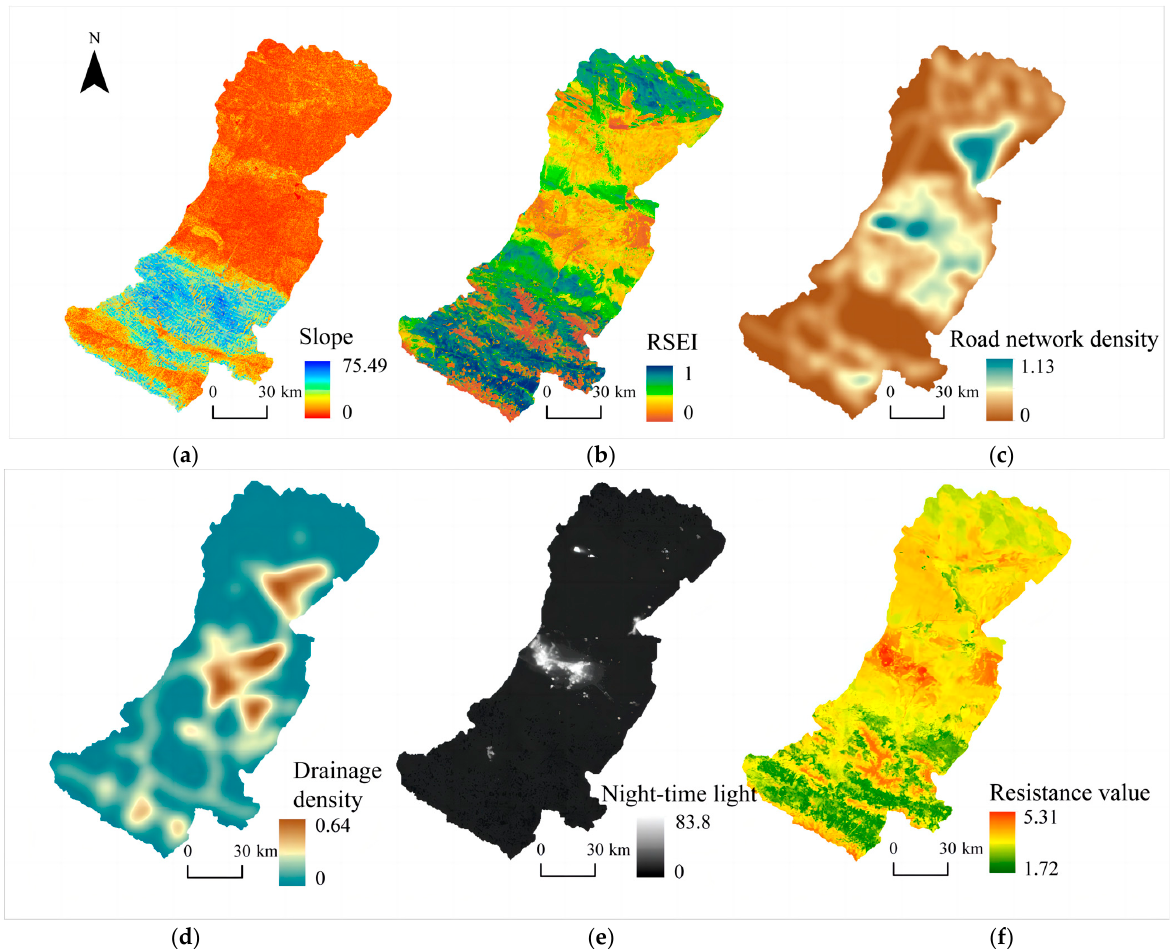
Figure 3. Build and correct resistance surface in Taolai River Basin: ( a ) slope; ( b ) RSEI; ( c ) road network density; ( d ) drainage density; ( e ) night-time light; and ( f ) resistance value.